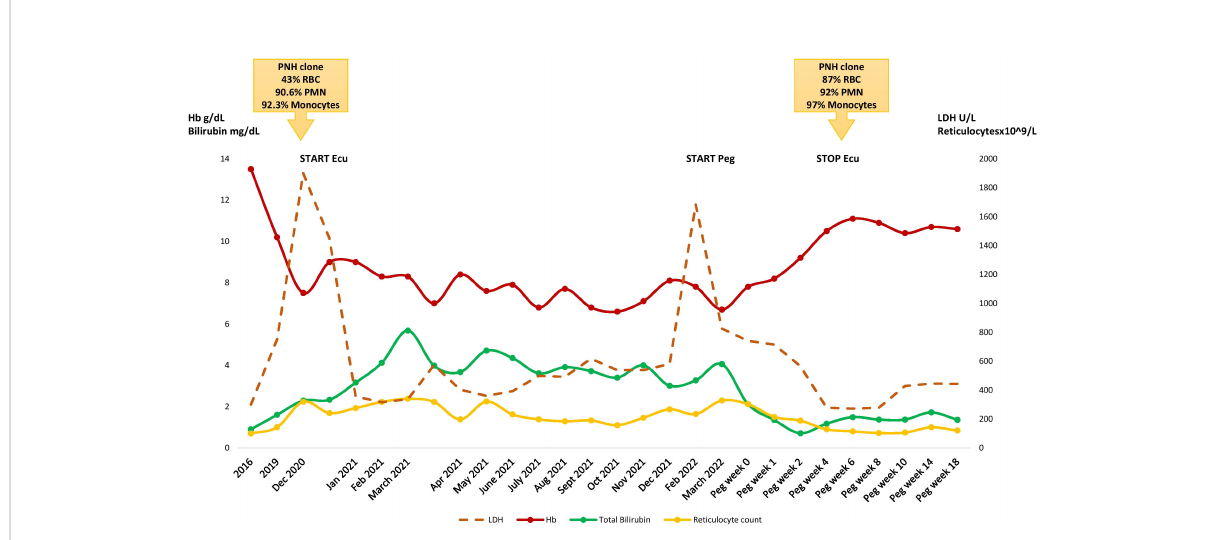
FIGURE 1 Hematologic parameters during the clinical course. RBC, red blood cells; PMN, polymorphonucleates; Peg, pegcetacoplan; Ecu,